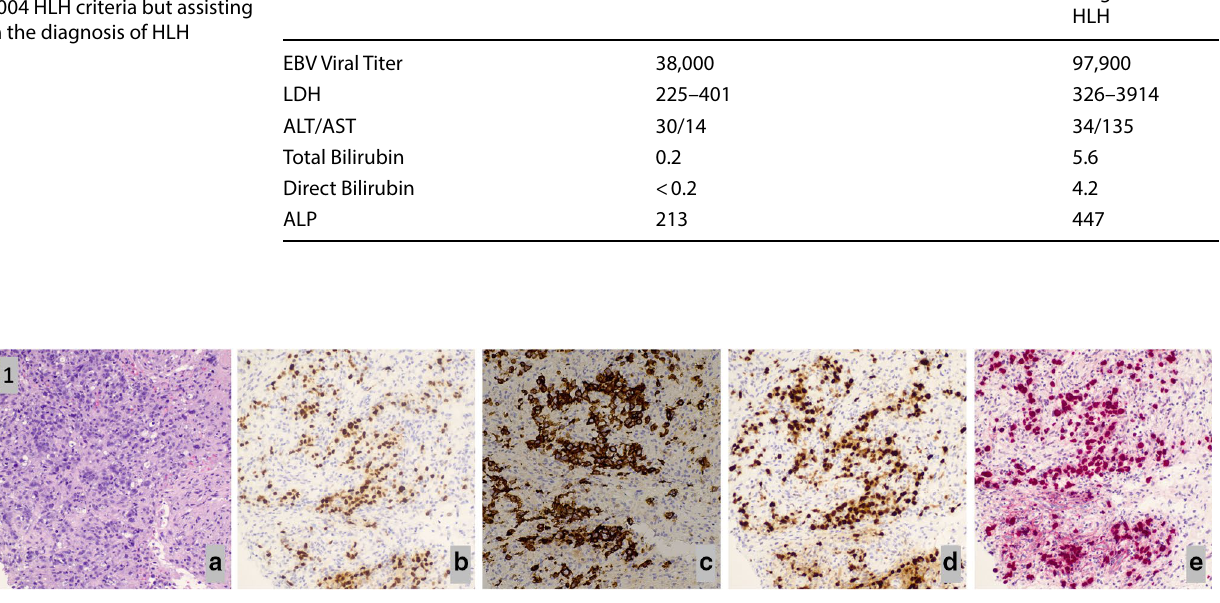
Fig. 1 a – e Retroperitoneal lymph node biopsy. H&E stained core biopsy of the retroperitoneal lymph node shows sheets and clusters of large, pleomorphic cells, with some showing prominent nucleoli. Numerous mitoses are observed. ( a , H&E). By immunostain, the cells are positive for Pax-5 ( b ), CD30 ( c ), and MUM-1 ( d ). EBER in-situ hybridization is positive ( e